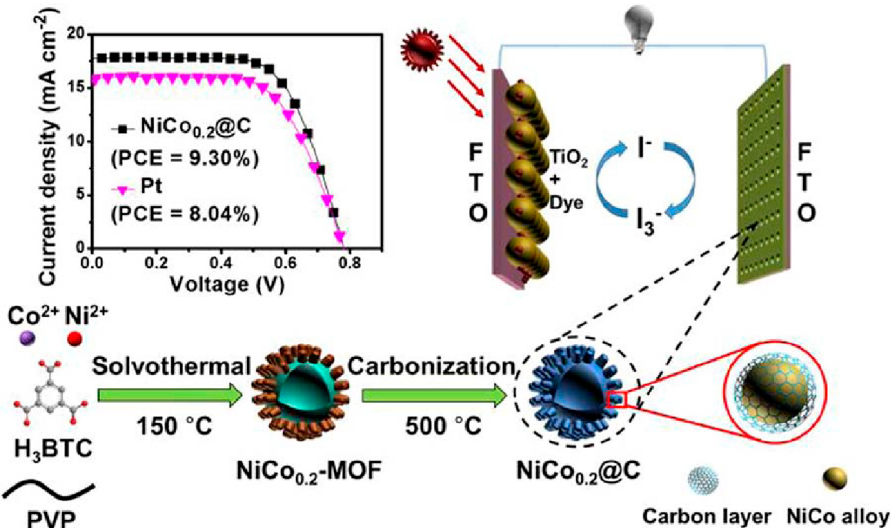
Figure 10. Schematic illustration of the formation process of NiCo 0.2 @C and cell performance. Reproduced with permission from ref. [176] .